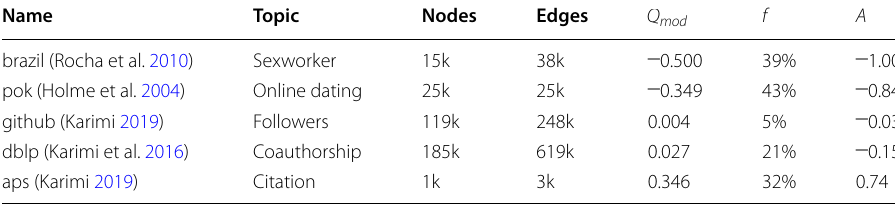
We use Q mod / A to denote the modularity/assortativity of the partition based on minority and majority label. The modularity is not obtained from an optimisation. Both metrics may be interpreted as a proxy for the homophily in the dataset. The fraction of the minority in the dataset is denoted by f . Our datasets cover a wide range of sizes, minority fraction and